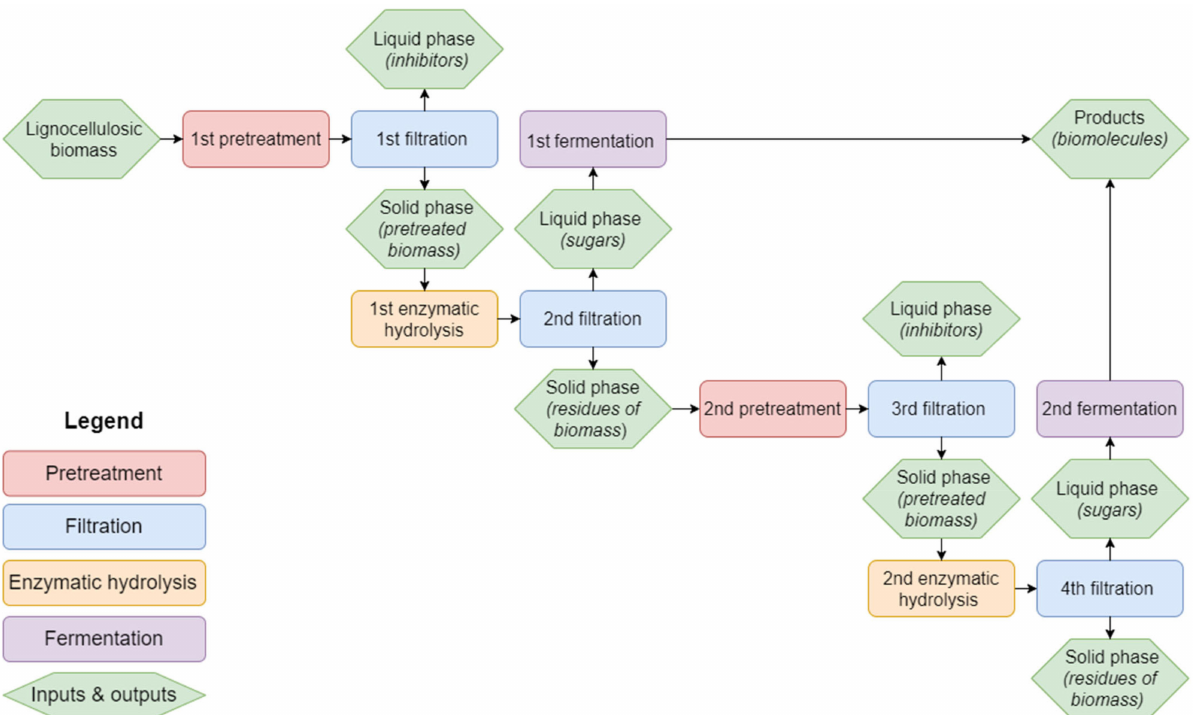
Figure 1. The process flow of the experimental setup. The process consists of pretreatment, filtration, enzymatic hydrolysis, and fermentation. Each process step is indicated with a rectangle box and distinguished by a color key (see legend). Inputs and outputs are shown as hexagons and colored light